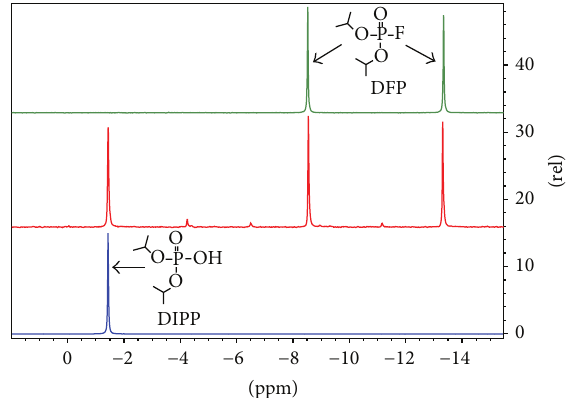
Figure 4: Purity results for synthesized DFP and commercial DFP when stored at − 10 ∘ C.